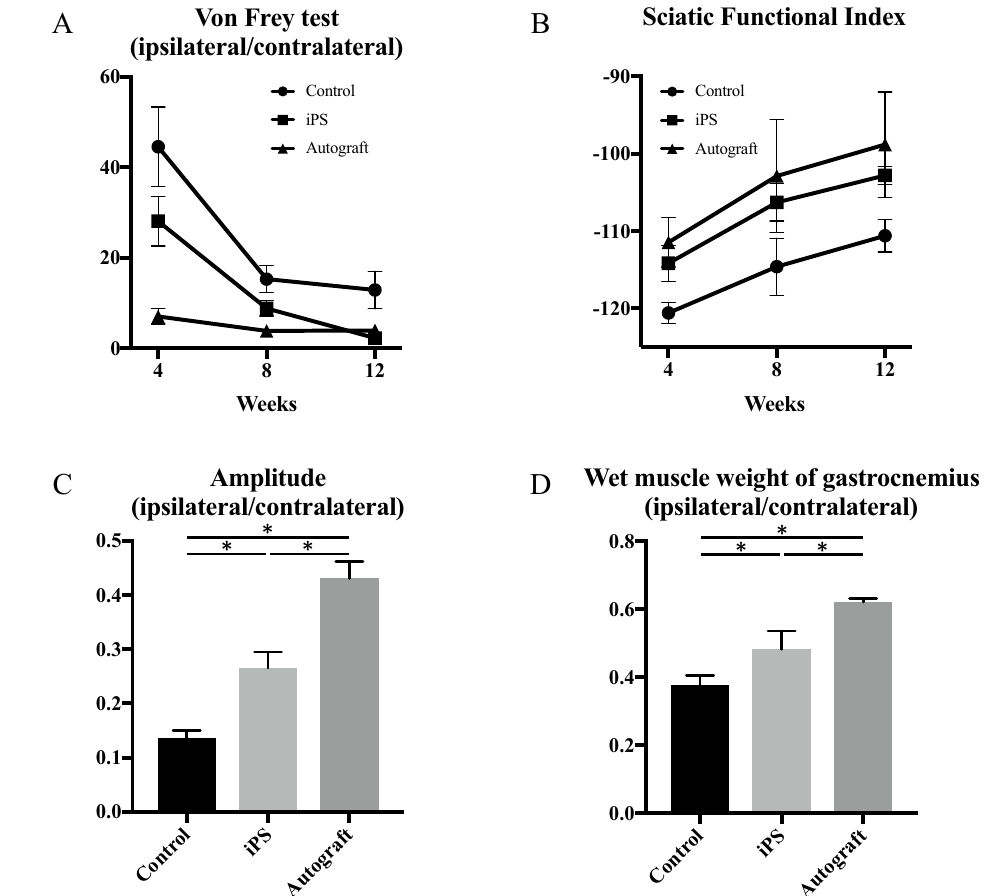
Figure 5. Sensory function assessed with the manual von Frey filament test ( A ) and motor function assessed with SFI of walking track analysis ( B ), amplitude of the CMAP of the gastrocnemius muscles ( C ), and wet muscle weight of the gastrocnemius ( D ) postoperatively. Representative gross appearances and HE-stained images of the gastrocnemius muscle ( E ). ( A ) Control group: 44.5 ± 8.8 (vs. iPS group: p = 0.07, vs. autograft group: p < 0.01), iPS group: 28.1 ± 5.5 (vs. autograft group: p = 0.02), autograft group: 7.0 ± 1.7 at 4 weeks, control group: 15.3 ± 3.0 (vs. iPS group: p = 0.04, vs. autograft group: p < 0.01), iPS group: 8.8 ± 1.7 (vs. autograft